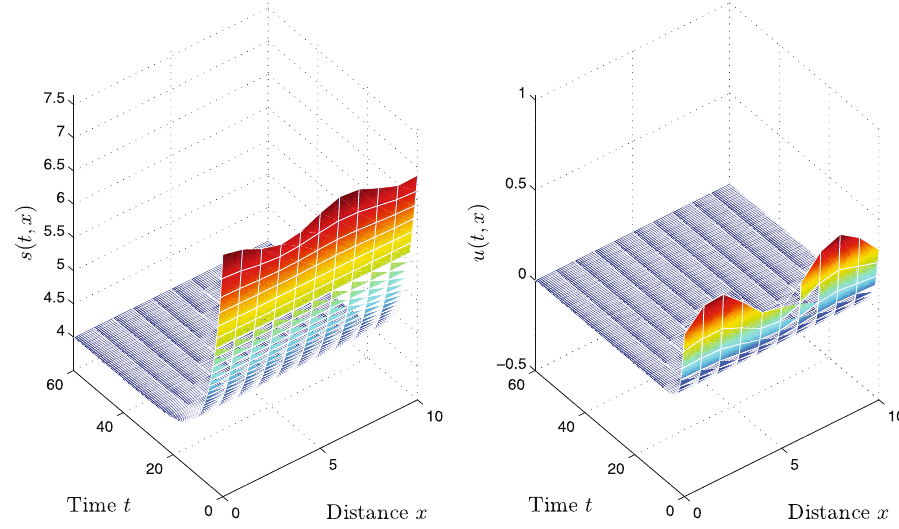
Figure 5: Numerical solutions of system ( 61 ) subject to the fi rst set of parameters.